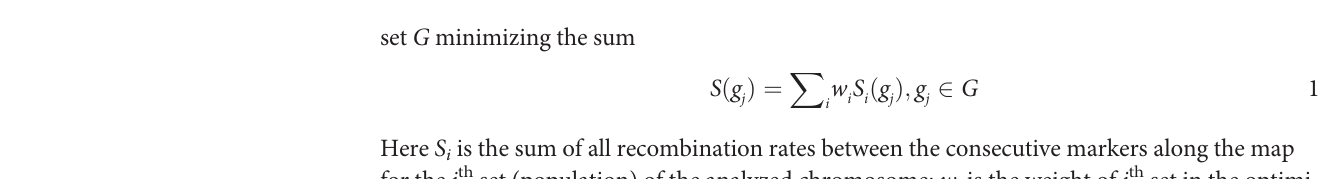
Fig 2. Main features and field of application of the two optimization methods (Globalheuristic and Local exact) for solving multilocus consensus mapping problems.